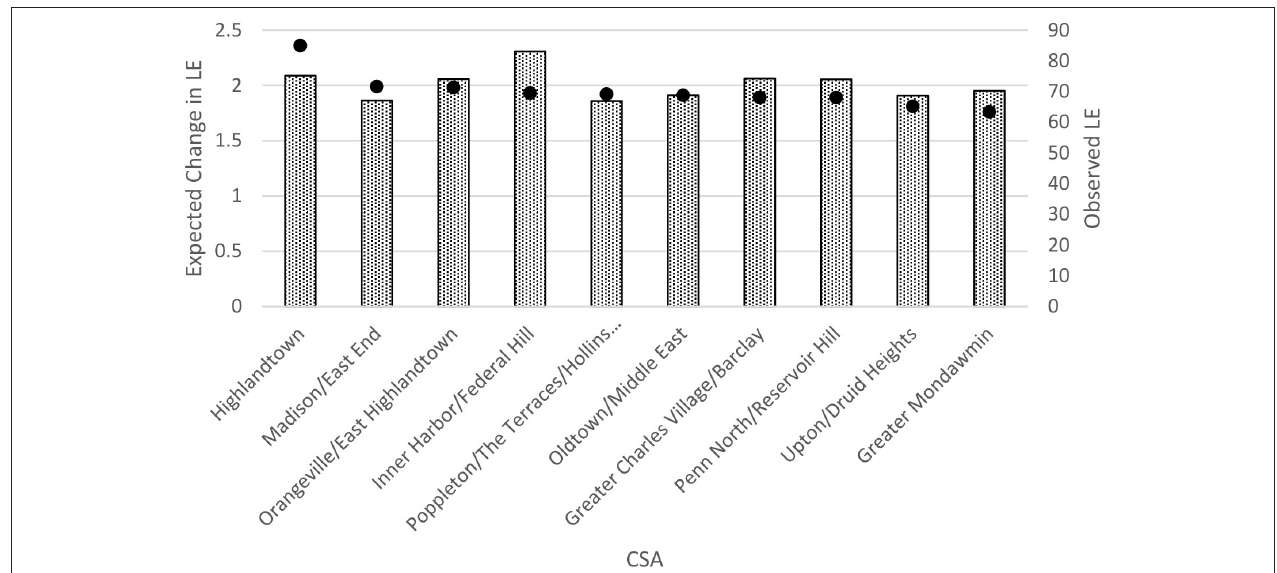
FIGURE 2 | Ten Baltimore city community statistical areas (CSAs) with greatest potential increase in life expectancy (LE) following a 20% reduction in heart disease deaths compared with observed LE in those CSAs. The bars represent the observed LEs, and the dots represent the expected change between expected LE and observed